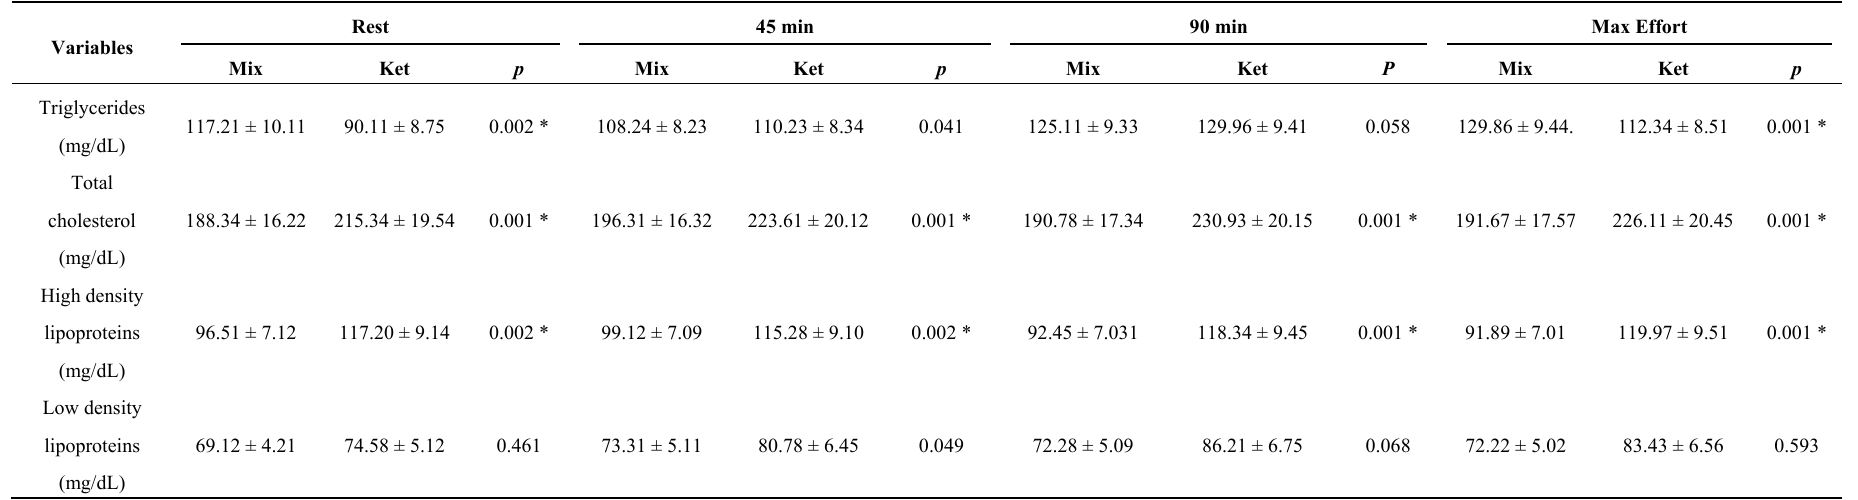
Table 4. Lipid and lipoprotein profiles during the mixed and ketogenic diets at rest and during the exercise protocol. Variables